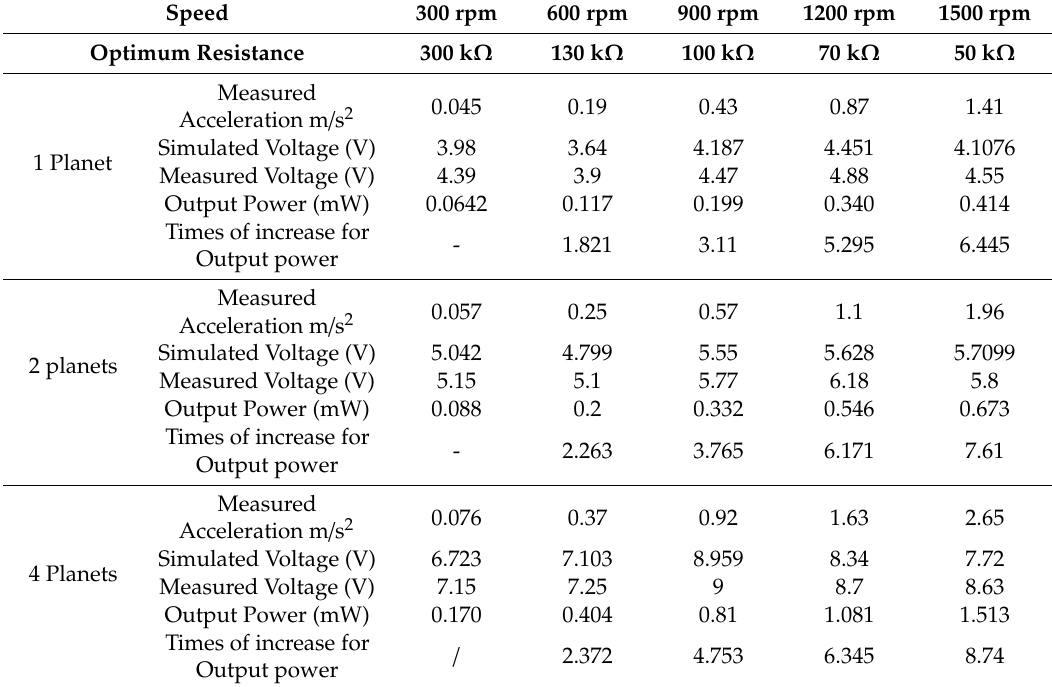
Table 2. Comparison of Voltage between Simulation and Experimental Results, as well as Output Power and Its Increase with the Rotational Speed Increase. Speed 300 rpm 600 rpm 900 rpm 1200 rpm 1500 rpm Optimum